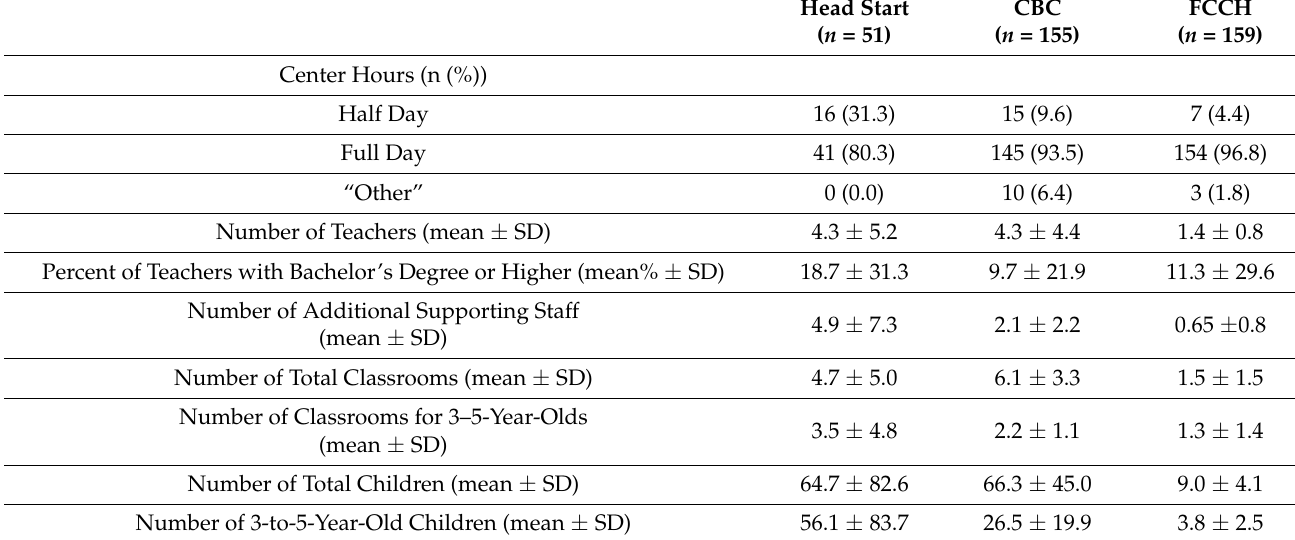
Table 1. Oklahoma Early Care and Education programs participating in the Communities and Classroom Health Survey in 2019/2020, by context ( n =